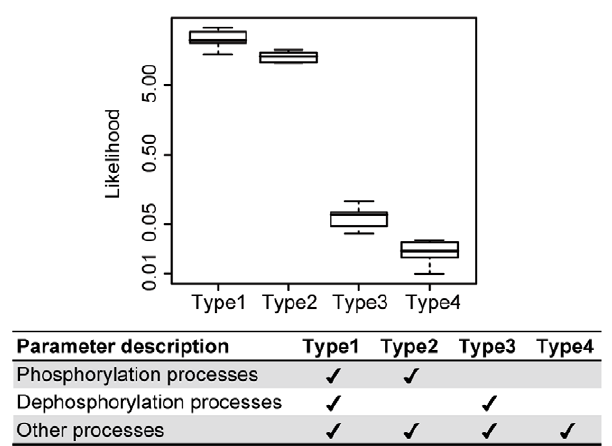
Figure 8. The enhancement of the phosphorylation rate is essential to reproduce the dynamics of Y992F signaling networks. Parameter estimation for the Y992F model was performed using different combinations of parameters indicated in the lower box (Types 1–4). Type 1 contains all 54 parameters, Type 2 contains 40 parameters without dephosphorylation processes, Type 3 contains 49 parameters without phosphorylation processes, and Type 4 contains 35 parameters without both phosphorylation and dephosphorylation processes. For each parameter combination, 10 independent parameter estimation processes were performed with 60 steps per process through data assimilation. The y-axis indicates the likelihood distribu- tion of the best model within each process, while the x-axis indicates the types for parameter combinations.